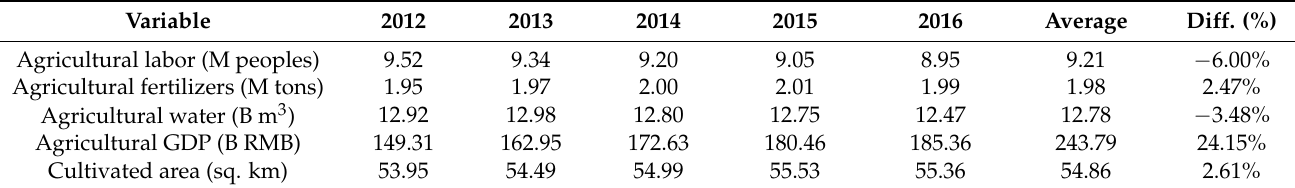
Table 4. Means and trend scenarios for each variable in each